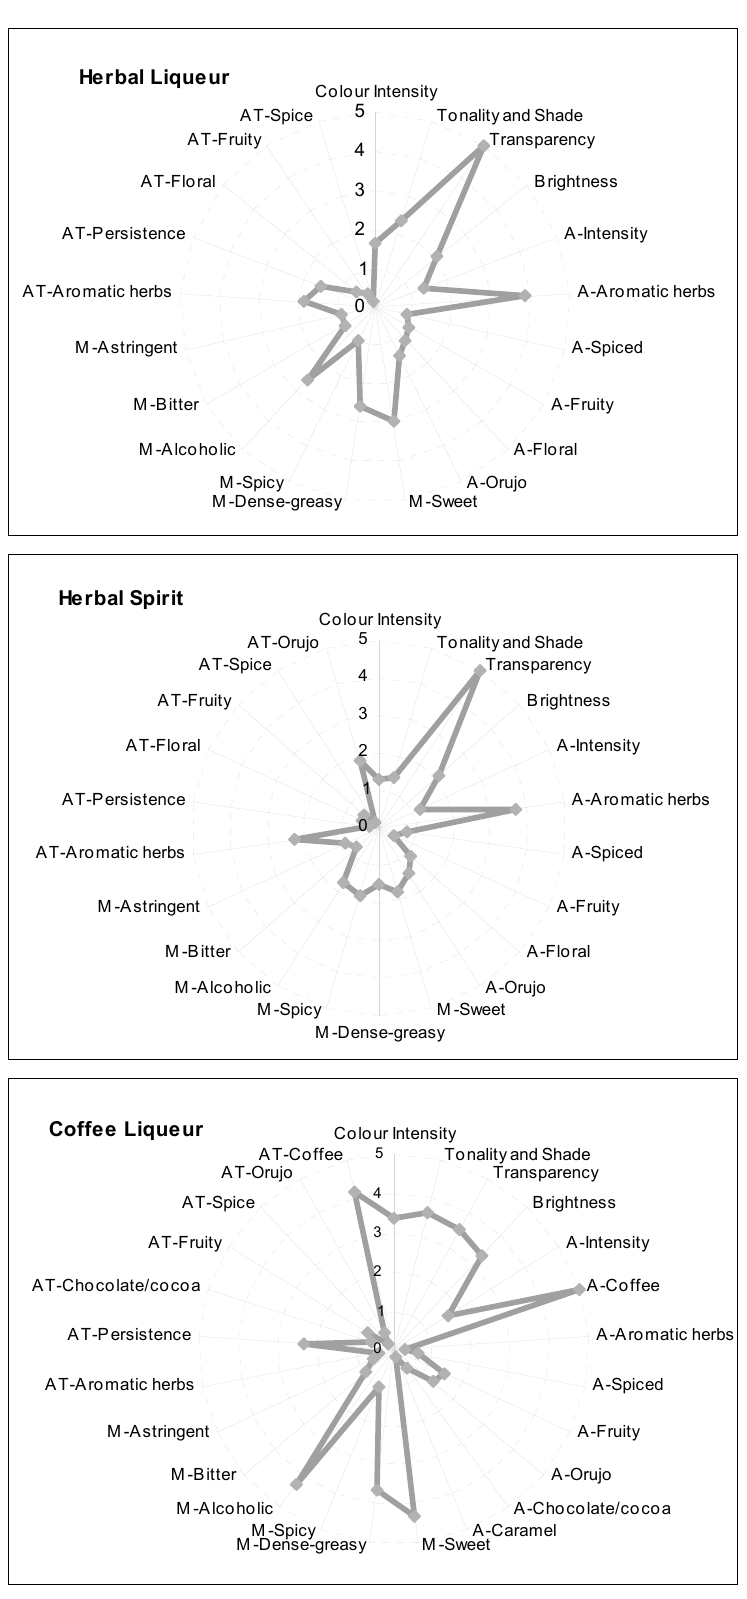
Figure 1. Sensory profile representing mean scores of the evaluated sensory attributes (A: aroma; AT: aftertaste; M: Mouth) for 232 herbal liqueurs; 19 herbal spirits and 213 co ff ee